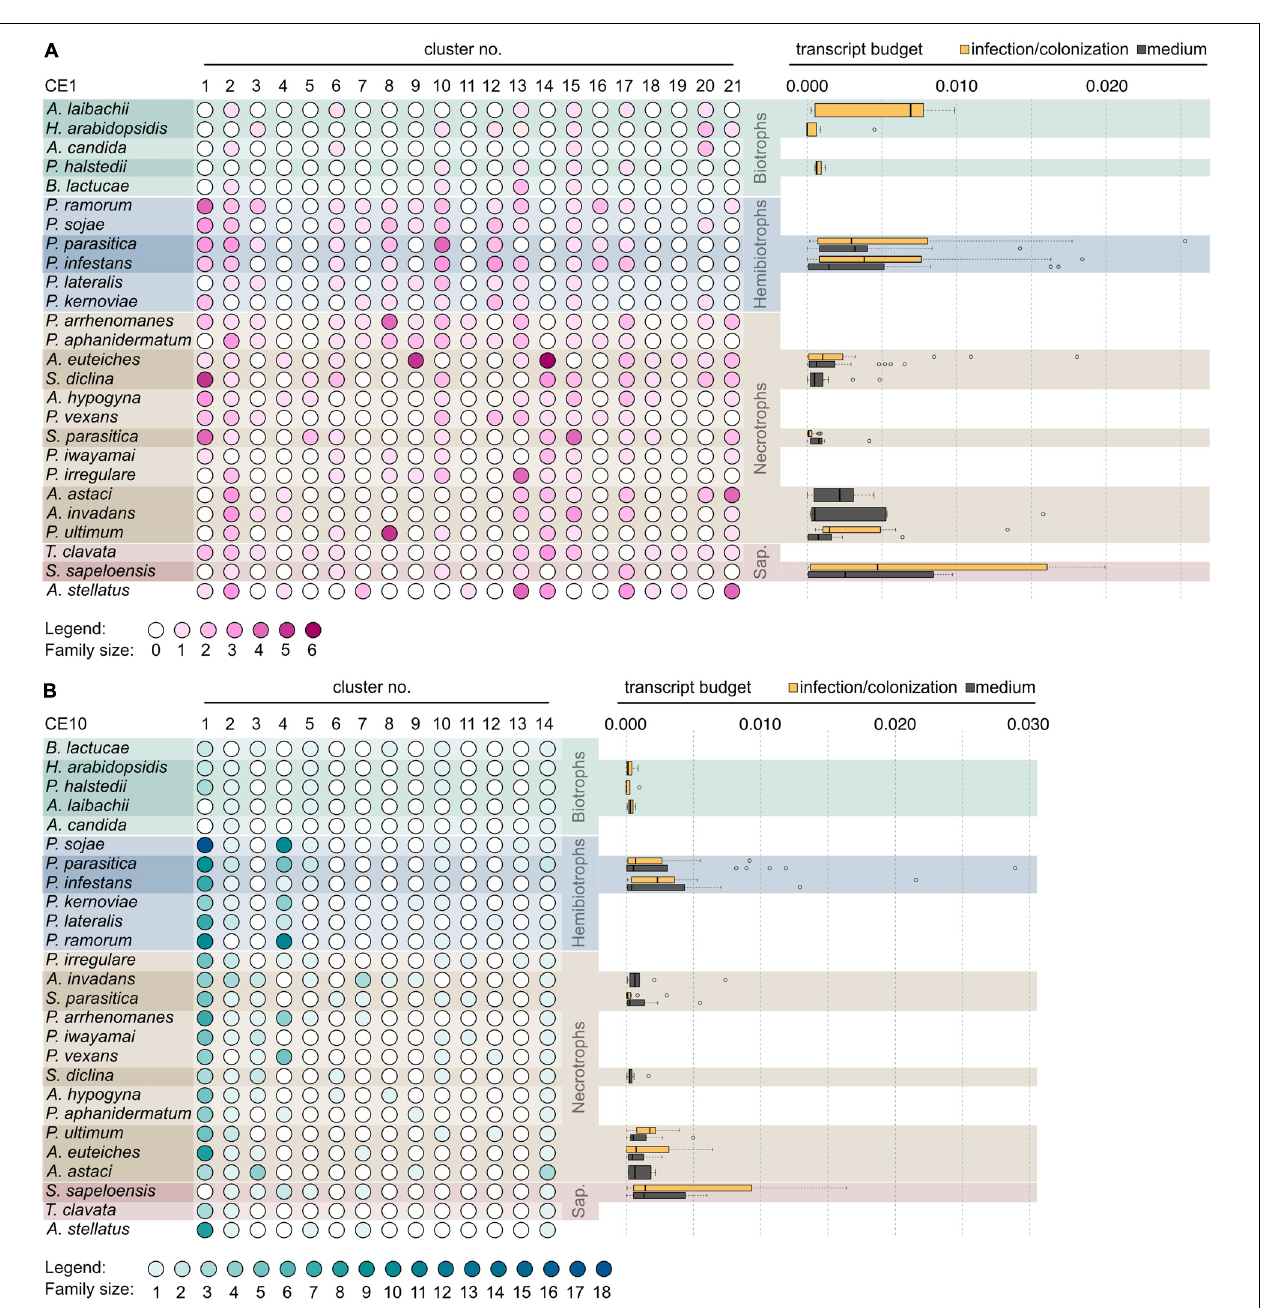
FIGURE 5 | Distribution of clusters of the carbohydrate esterase 1 (CE1) and 10 (CE10) families across oomycetes. Heat map of gradient-colored dots that depicts the size of the clusters of the CE1 ( A , pink) and CE10 ( B , teal) gene families in 26 oomycetes. Cluster labels are based on Figures 3 , 4 . The darker a dot, the more genes were found in a given cluster. The species are clustered by lifestyle, followed by numbers of clusters present. The box plots to the right of the matrix give the expression as transcript budget of CE1- and CE10-encoding genes across each species. The yellow box plot shows the expression during infection or colonization (in case of the saprotroph S. sapeloensis ), and gray box plots give expression during mycelial growth on artificial medium.